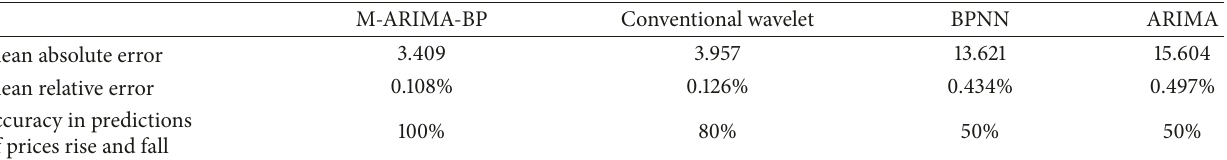
Table 4: Comparison of the prediction results of Shanghai Stock